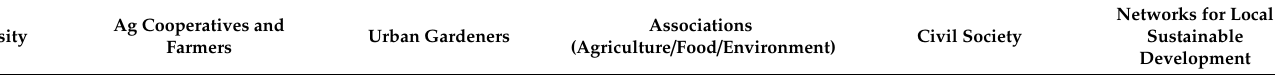
Table 2. Thematic areas and common projects developed during the participatory process (Source: own